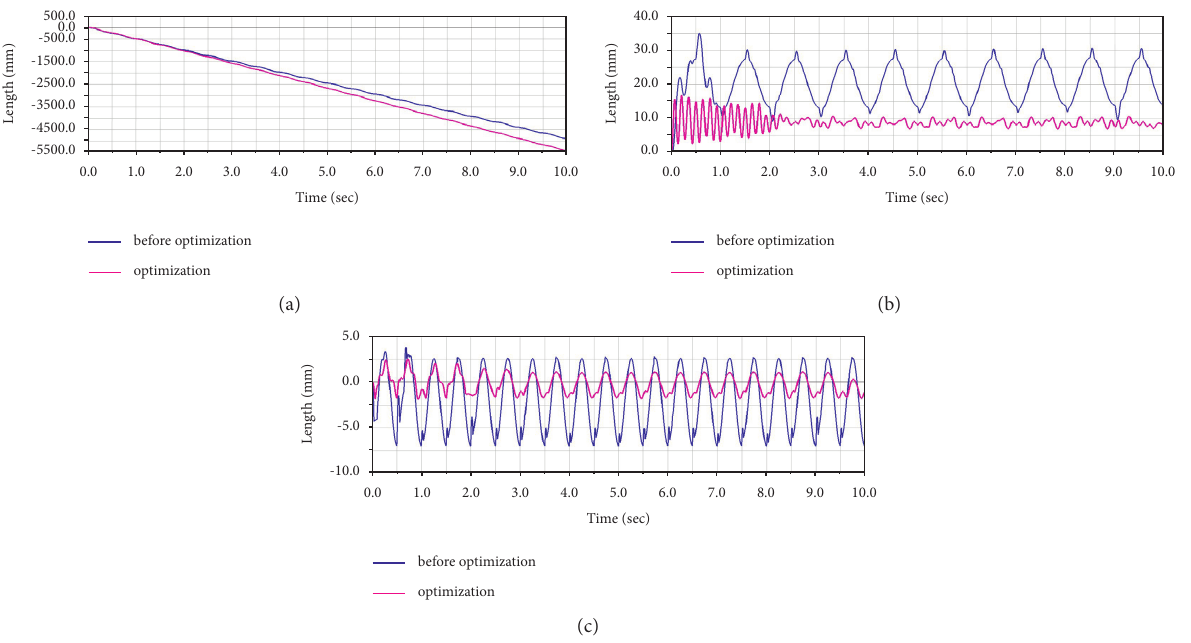
Figure 6: Body CoM displacement curve. (a) Forward curve; (b) lateral curve; (c) vertical body interference proposed in this paper. The optimization curve represents the data obtained by using the body in- terference control method proposed in this paper.